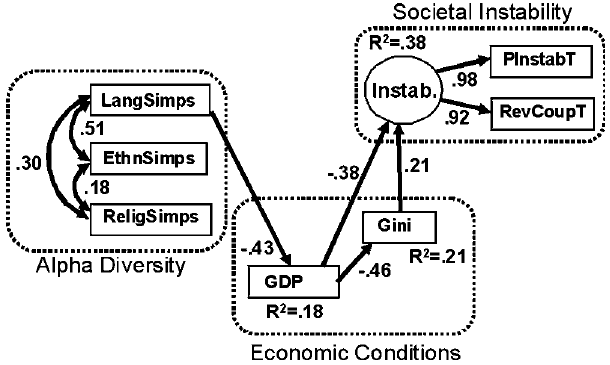
Figure 4. SEM results for model including only a diversity measures (for comparison against Fig.